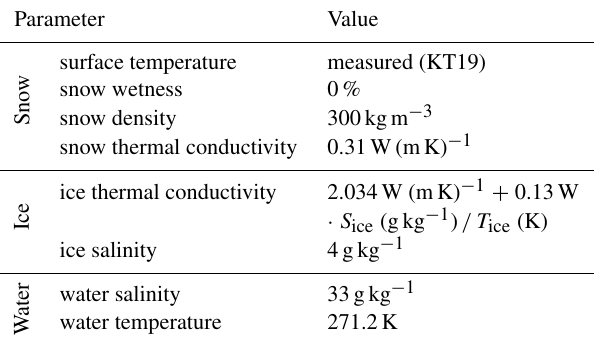
Table 1. Brightness temperature simulation setup of the MIcrowave L-band LAyered Sea ice emission model